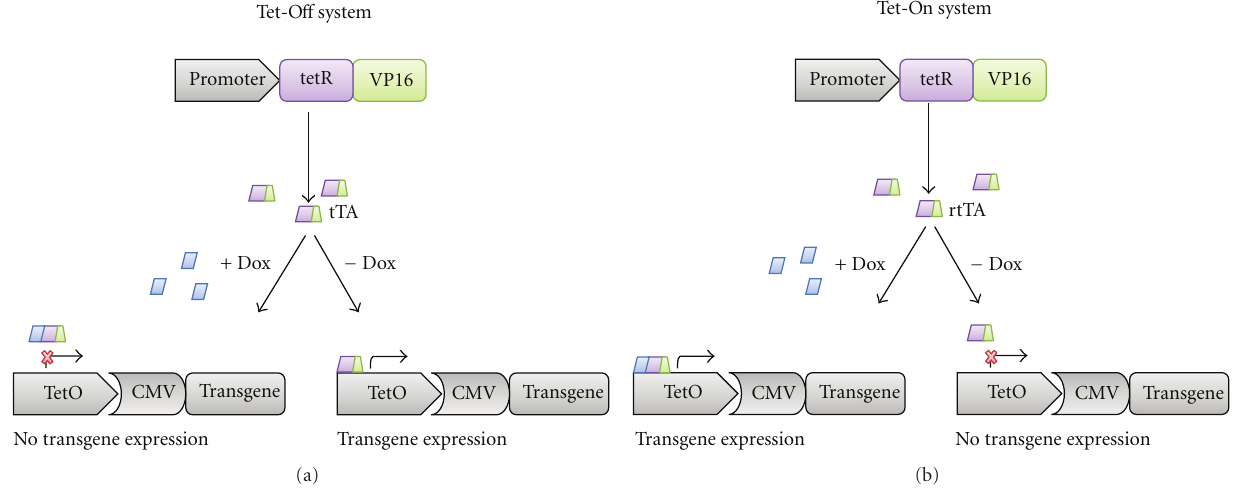
Figure 1: Mechanics of tetracycline regulated systems. A constitutively active promoter drives expression of tetracycline transactivators (tTAs) or reverse tetracycline transactivators (rtTAs). (a) Tet-O ff system. tTAs are able to bind to the tet-operator sequence (tetO) in the absence, but not in the presence of doxycycline (dox) to drive transgene expression. (b) Tet-On system. rtTAs are able to bind to the TRE in the presence, but not in the absence of dox to drive transgene expression. tetR: tetracycline repressor; VP16: viral protein 16; CMV: cytomegalovirus.